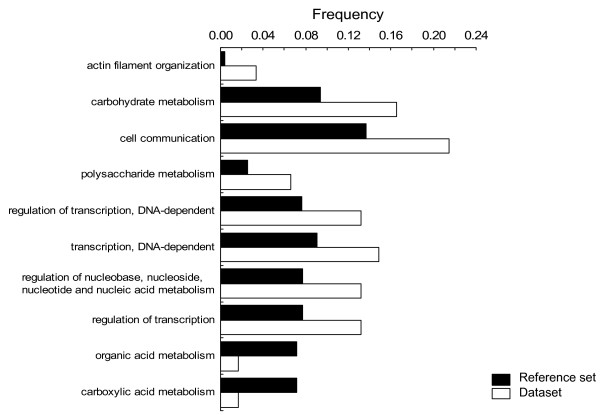
Genes grouped by gene ontology (GO) terms. For all statistical significance categories, the bars in the reference set plot the subset frequencies of annotated genes in the cDNA microarrays belonging to a particular class with valid gene expression data for statistical analysis (Fig. 1), and the bars in the dataset represent those frequencies in the group of genes labeled as 'differentially expressed' when contrasting the two extreme thermal regimes. Two categories are apparently underrepresented (organic acid and carboxylic acid metabolism), whereas the rest are overrepresented in the dataset [see Additional file 2].